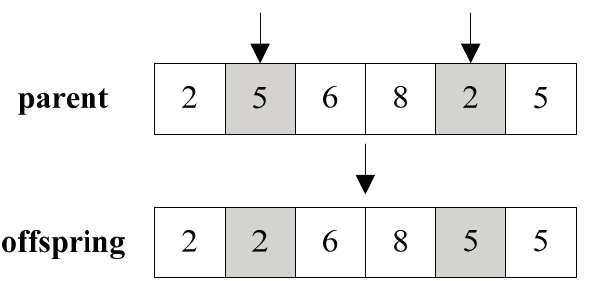
Figure 3. Illustration of mutation operation.